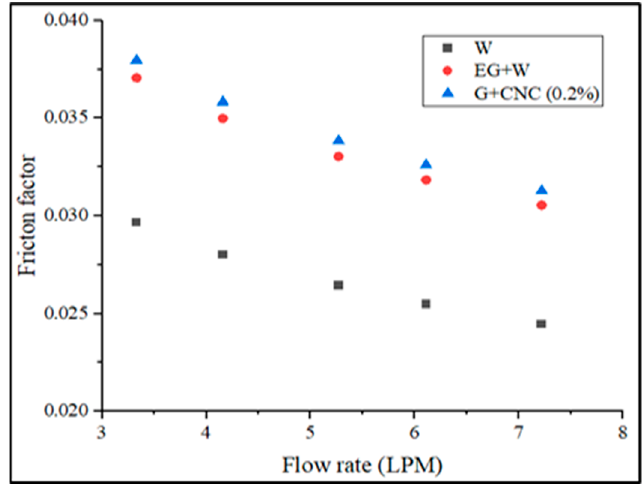
Figure 12. Friction factor vs. flow rate in LPM.